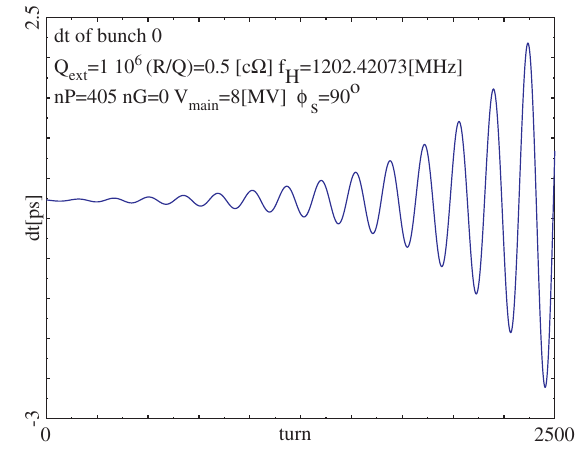
FIG. 3. (Color) Program check: Chosen bunch (#0) in LHC showing a synchrotron oscillation of dt with a frequency of about 65 Hz (displayed on 2500 machine turns (cid:6) 220 ms ) with an exponentially growing amplitude due to coupled bunch instabilities (CBI).